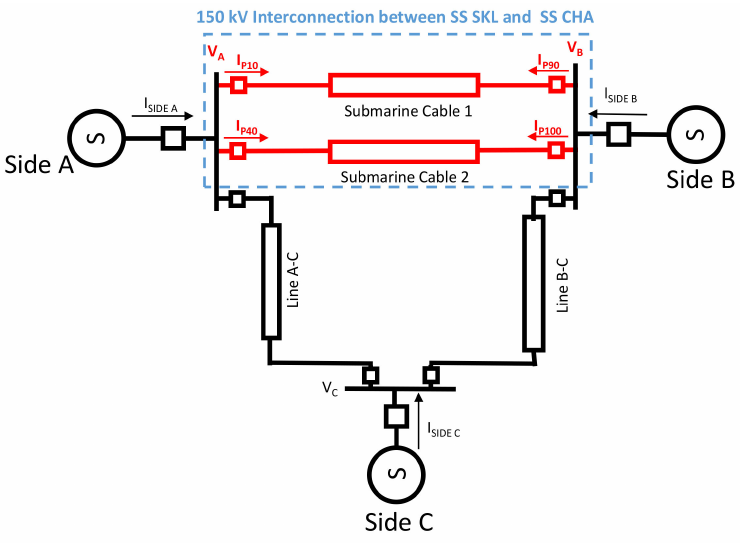
Figure 16. Protection zones implemented in the submarine interconnection between “SS SKL” and “SS CHA”.